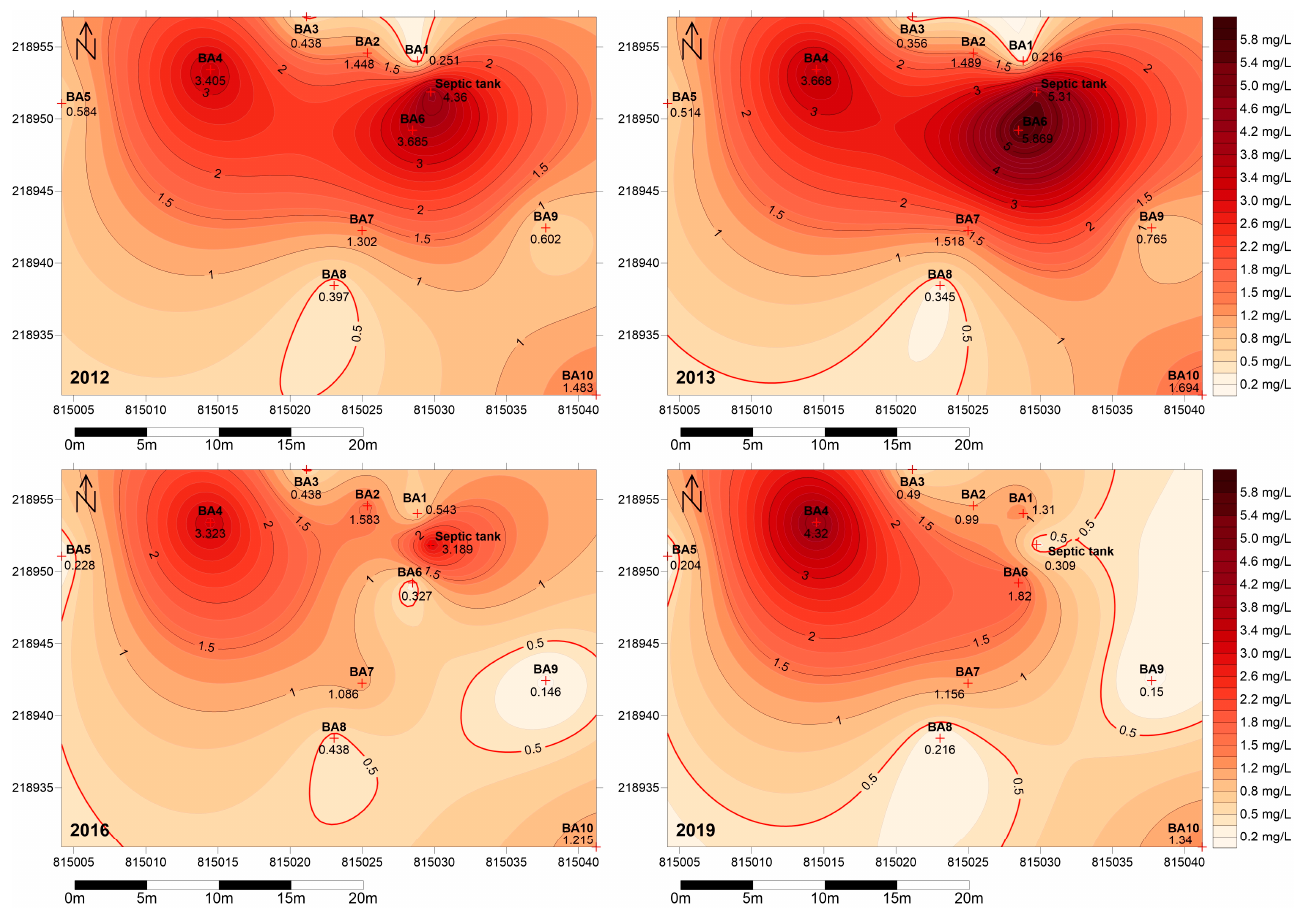
Figure 7. Spatial distribution maps of PO 43 − concentrations in the years before (2012, 2013) and after (2016, 2019) the elimination of the septic tank.